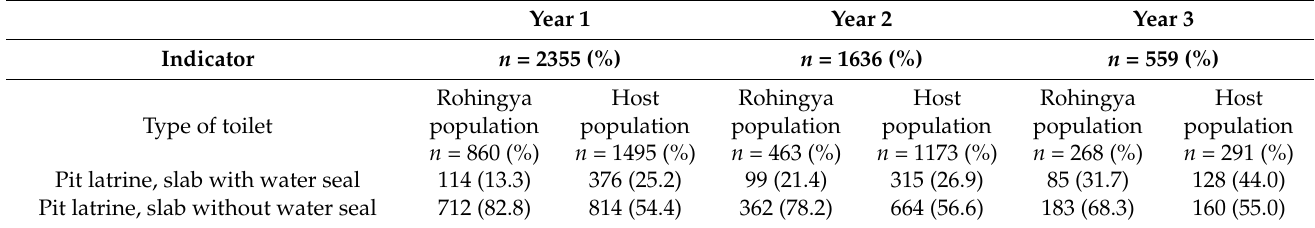
Table 3. Changing trend of use of pit latrine with water seal and without water seal by the Rohingya population and neighborhood host-country population over three years in Teknaf and Ukhia sub- districts, Cox’s Bazar, Bangladesh